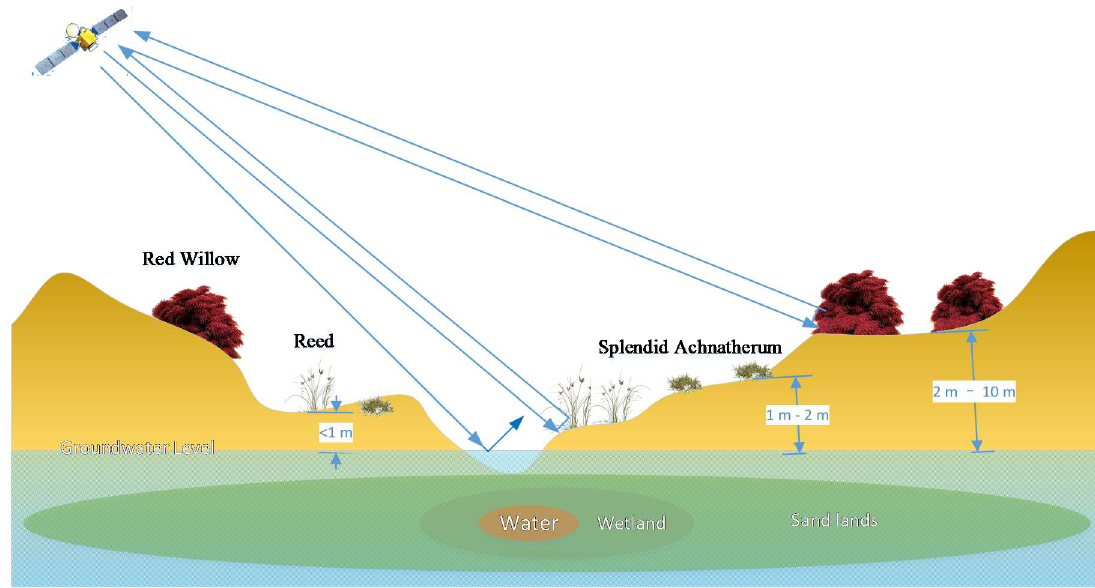
Figure 12. The correlation between arid land vegetation and the groundwater level. As a depth to the groundwater of less than 2 m, phreatophytes including reeds and splendid achnatherum are the dominant plants; at a depth between 2 m and 10 m, psammophytes are the dominant plants; at a depth greater than 10 m, few plants are found [41].